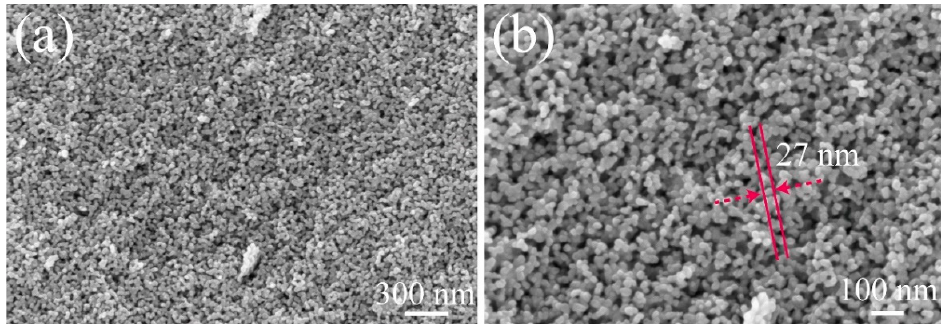
Figure 3. ( a ) FE-SEM images of CM/T (100 K X); ( b ) FE-SEM images of CM/T (200 K X).